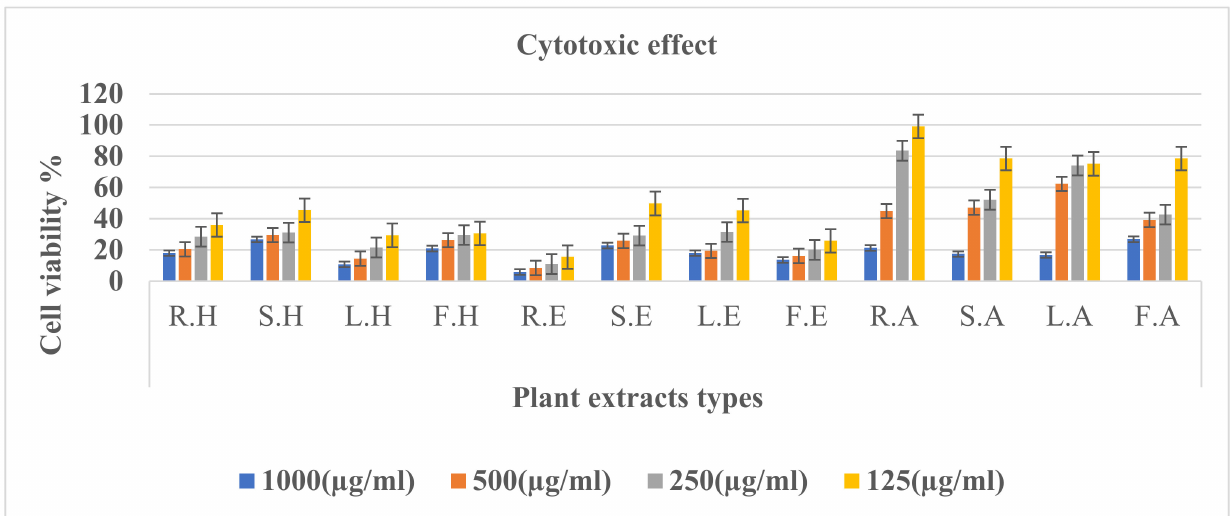
Figure 4. Cytotoxic effect of Micromeria fruticosa extract on colon cell line viability at different concentrations after 24 h. R: root, S: stem, L: leaf, F: flower, H: hexane, E: ethanol, and A: aqueous. The bars correspond to means of two replicates ± standard